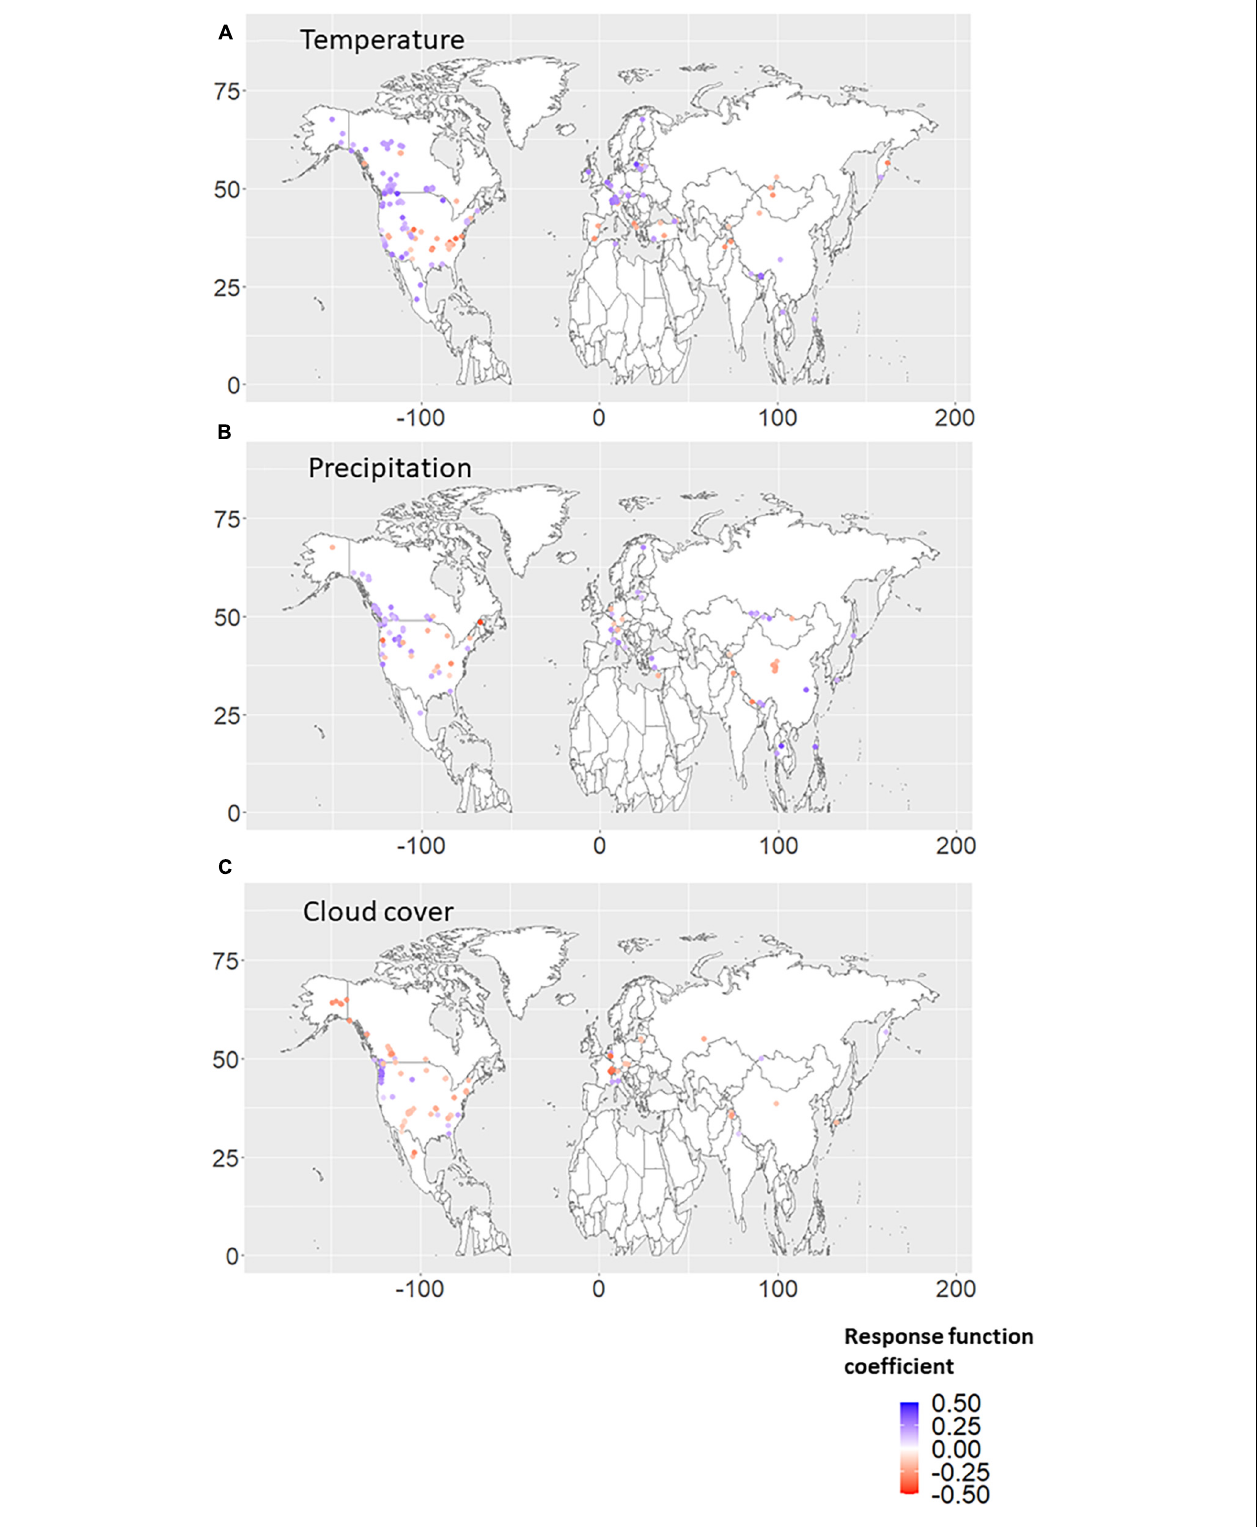
FIGURE 3 | Response function (RF) coefficients between RWI and climate variables, i.e., (A) temperature, (B) precipitation, and (C) cloud cover, in the autumn season of the current year. The period when both RWI and climate data existed in duplicate during 1901–2016 was used for the analysis. Only the RWI sites where the RF coefficient was significant ( p < 0.10) are